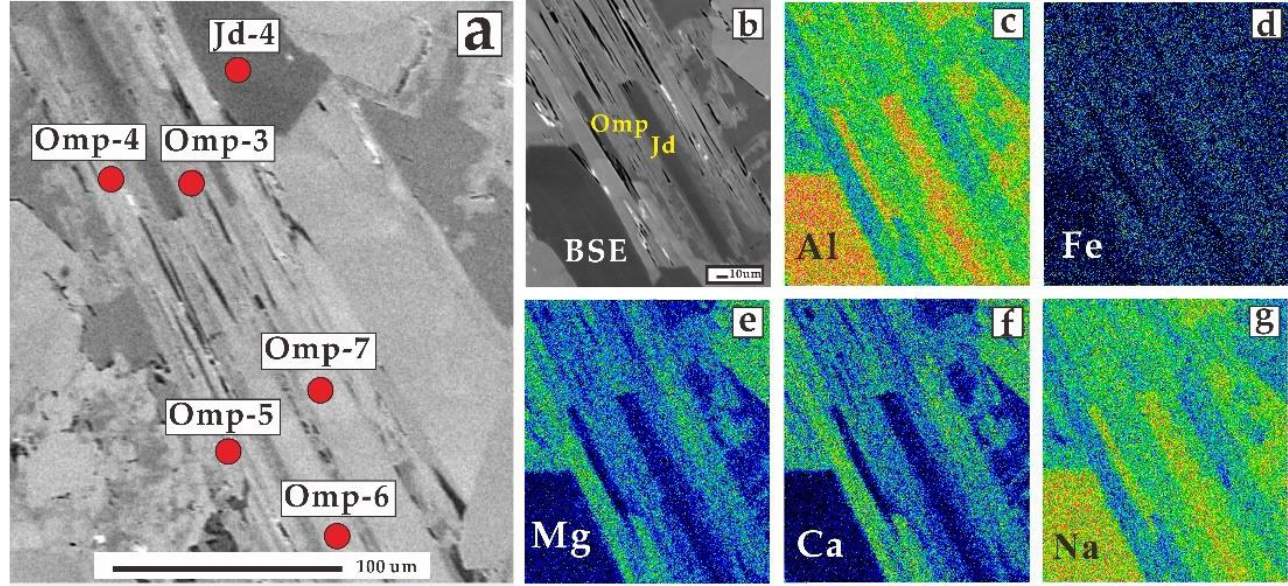
Figure 6. ( a ) BSE image of the testing positions of jadeite and omphacite exsolution corresponding to Table 1; ( b – f ) EDX mapping analysis showing major element composition variations among them.